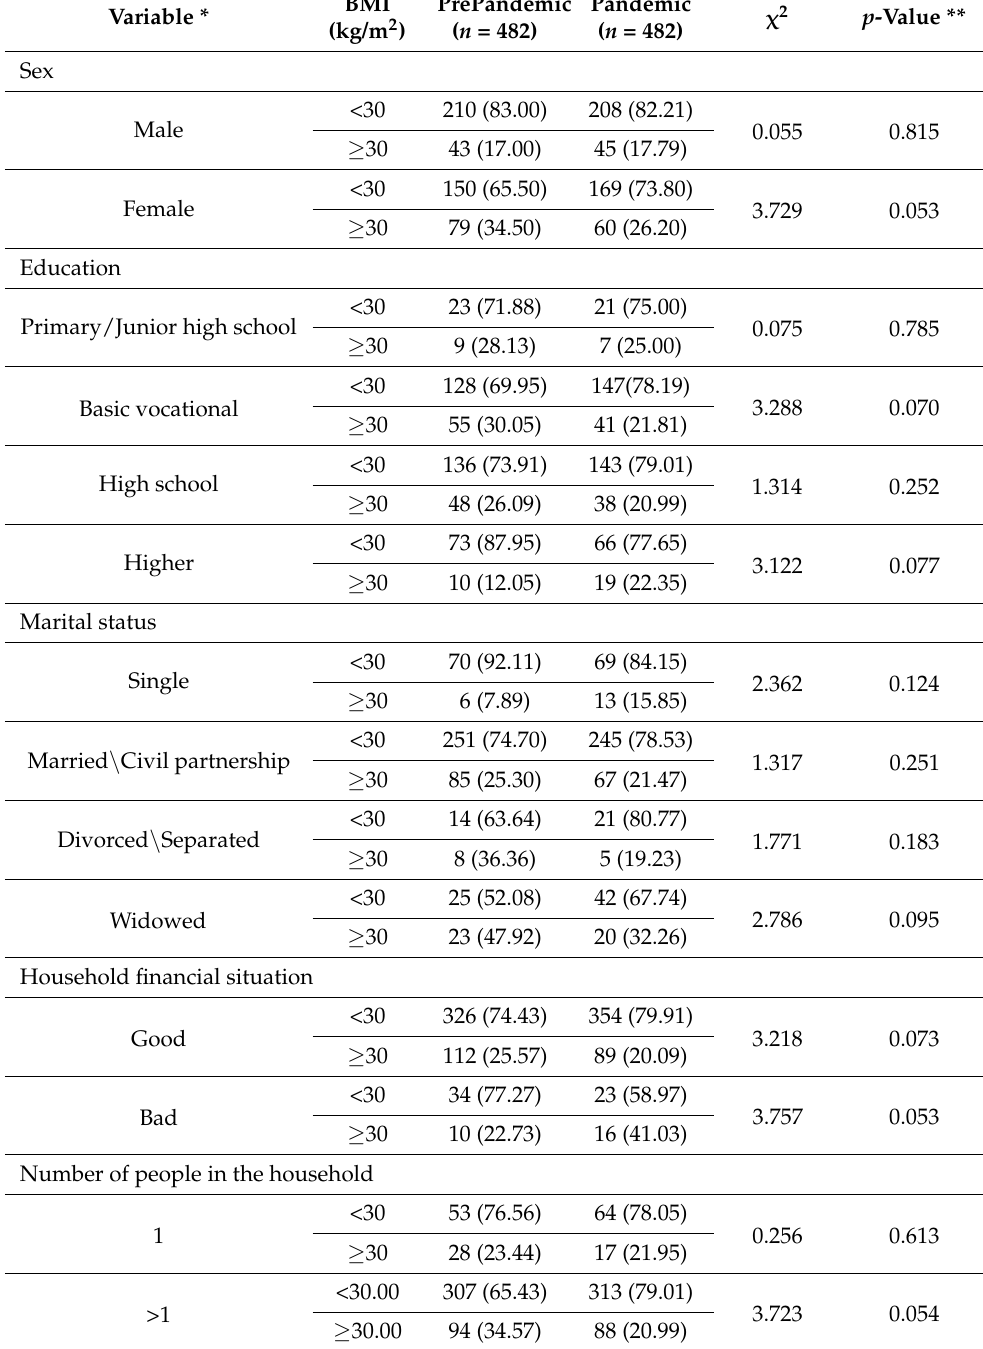
(Table 3), age (Figure 1) or BMI (Figure 2). Table 3. Study group